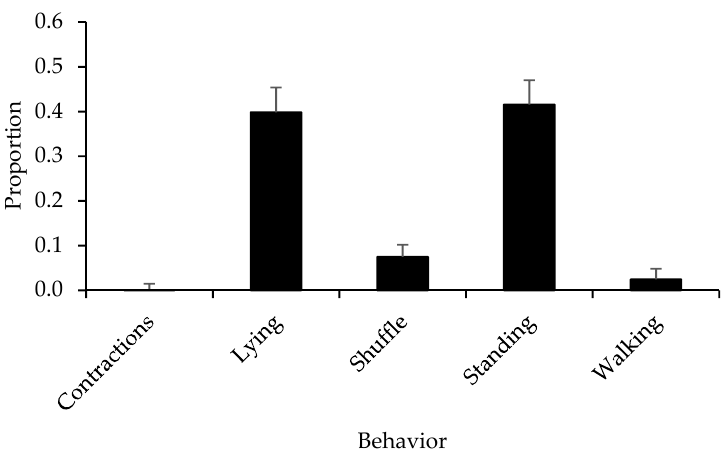
Figure 1. Predicted mean ( ± SEM) proportion of time spent in doing different behaviors. Table 1. Effects of parity, time period, and lambing assistance on the duration of behaviors as a proportion of time.